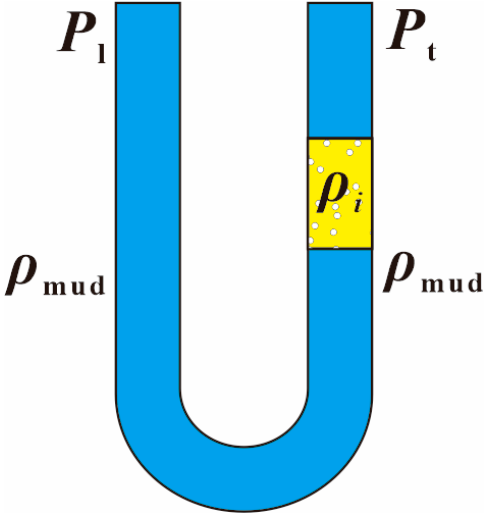
Figure 1. Schematic diagram of the U-tube principle.